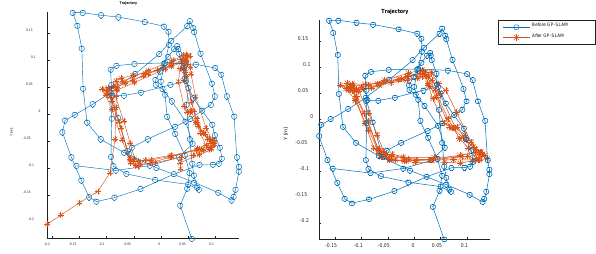
Figure 10: The recovered square trajectory under a near homogeneous magnetic field using GP-SLAM. (Left) Using the squared exponential kernel and (Right) curl-free and divergence- free